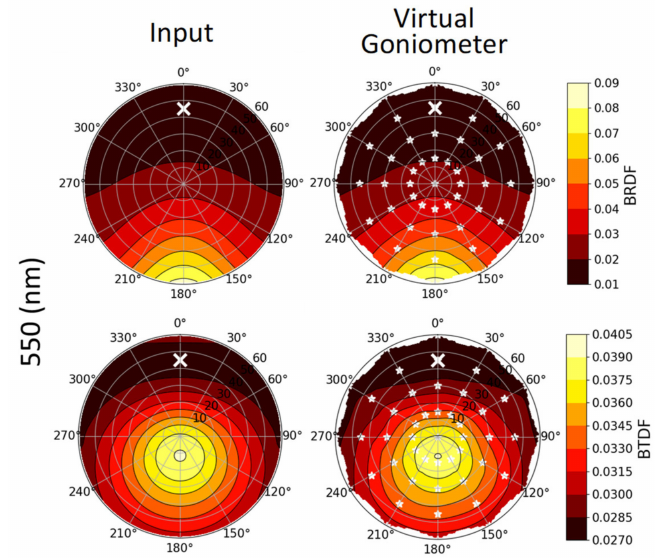
Figure 5. Comparison at 550 nm of bidirectional reflectance distribution function (BRDF), top row, and bidirectional transmittance distribution function (BTDF), bottom row, between input BSDF material properties, left column, and a simulated goniometer in DIRSIG, right column. The illumination source is set at 45 ◦ with view angles in 30 ◦ azimuth steps (0 ◦ –360 ◦ ) and 15 ◦ zenith steps (0 ◦ –60 ◦ ) for the goniometer. The white “x” depicts the source angle, while white stars represent the measured locations of the